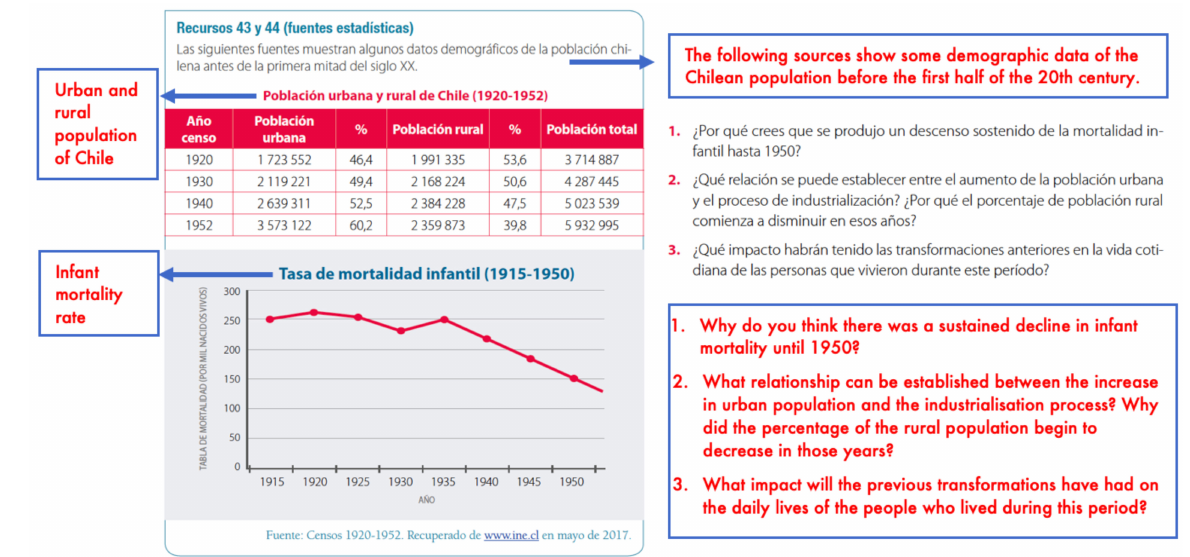
Figure 14. Example of initial mixed representation task (Adapted from [35] (p.